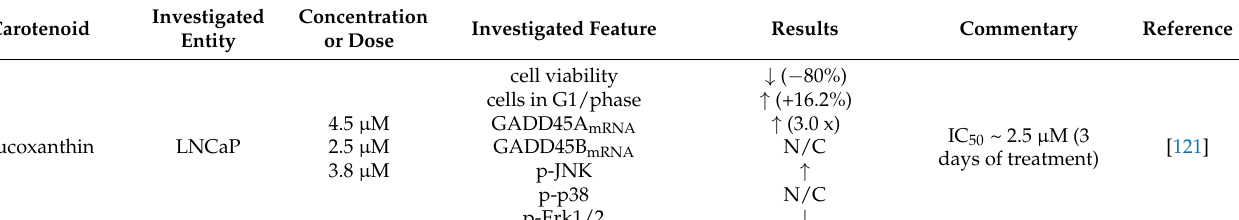
Table 5. Summary of results of laboratory studies investigating the impact of additional carotenoids (other than lycopene and β -carotene) on PC cell lines.